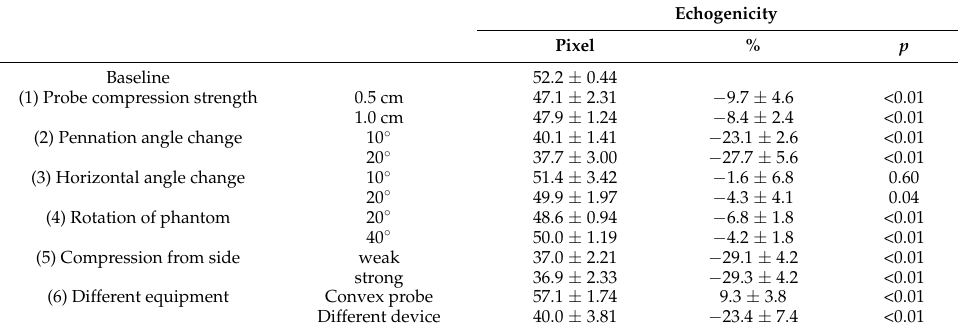
Table 3. Echogenicity in various